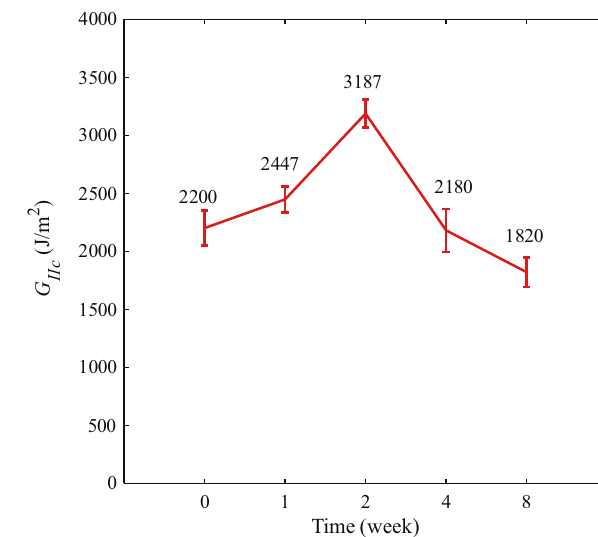
Figure 8: Fracture toughness in mode II for samples exposed to an acidic environment at 25°C.